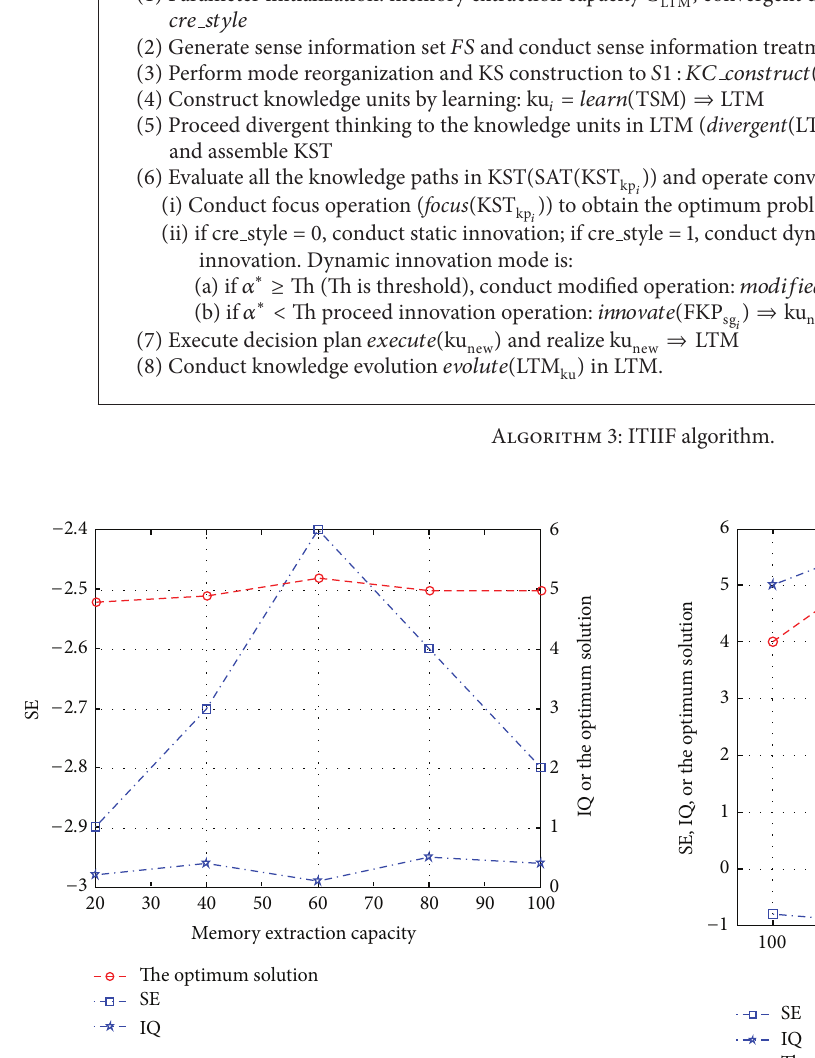
Figure 4: The relationships of 𝐶 with thinking set degree, LTM information quantity, and the optimum solution. Figure 5: The relationships of STM with thinking set degree, information quantity, and the optimum